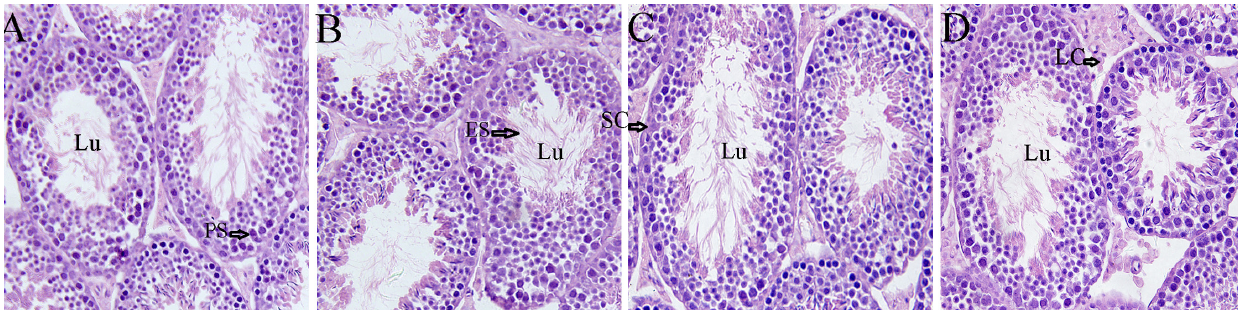
Figure 3. Histology of the testes in SD rats after treatment with different doses of icariin (×200). ( A ) Control, ( B ) 50 mg/kg icariin, ( C ) 100 mg/kg icariin, ( D ) 200 mg/kg icariin.